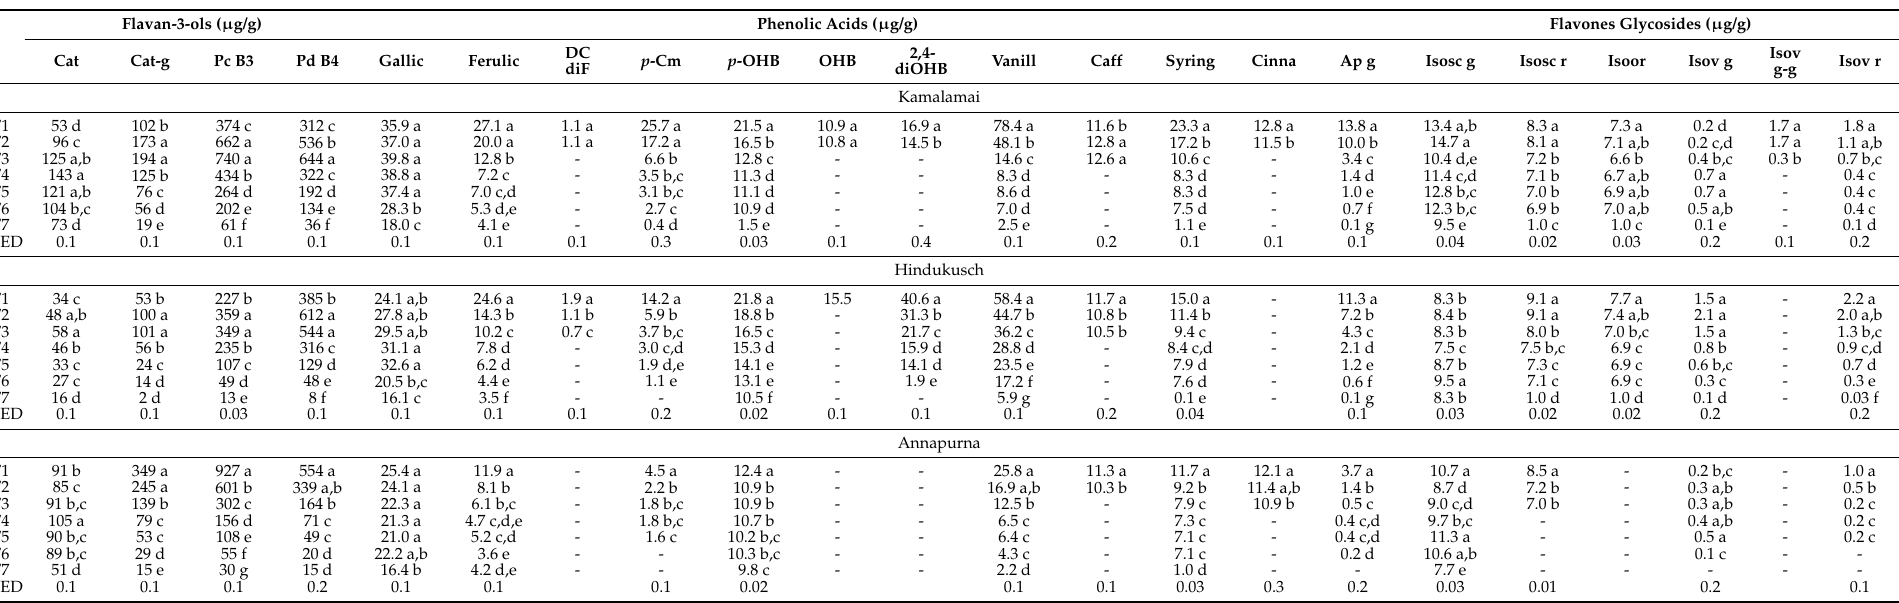
Table 4. Free phenolic compounds contents in barley pearling